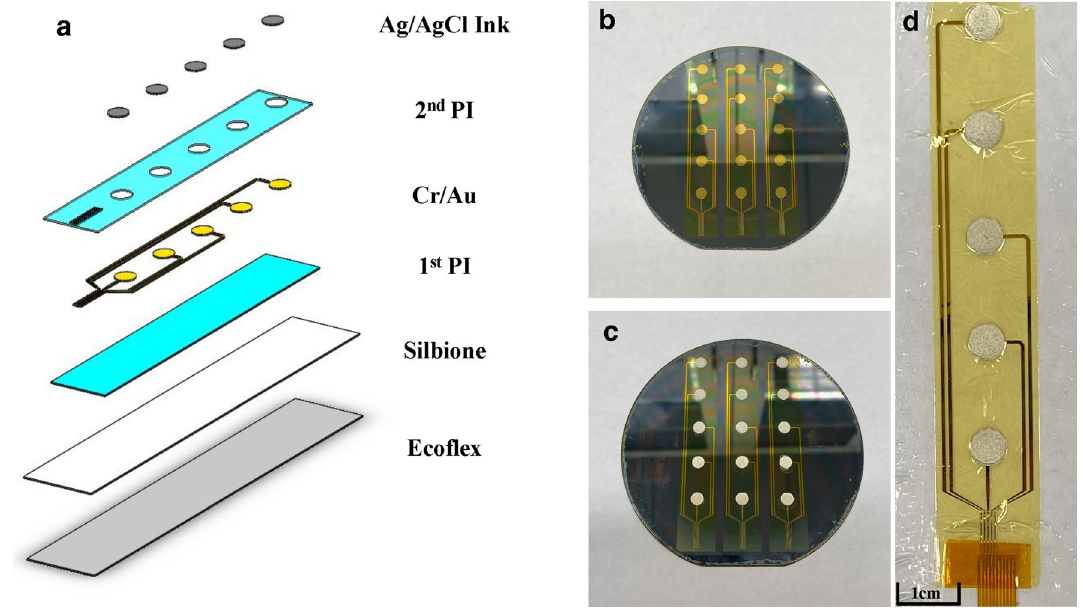
Figure 1. Custom surface electrode array for non-invasive testing of cervical neuronal activity. ( a ) Device cross section (5 mm sensor diameter and 500 μm interconnect width). ( b ) Cleanroom post-processed wafer ready to be printed with Ag/AgCl ink. ( c ) Ag/AgCl ink screen-printed wafer on the active electrode region. ( d ) Device transfer-printed onto a self-adhering flexible silicone substrate (Ecoflex/Silbione) on PET backing via water soluble tape.